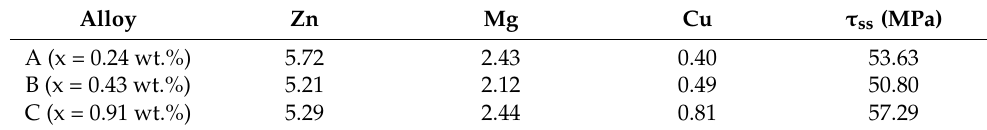
Table 6. Solute concentration of Al-5Zn-2.6Mg-xCu alloy and strength of solid solution. Alloy Zn Mg Cu τ ss (MPa) A (x = 0.24